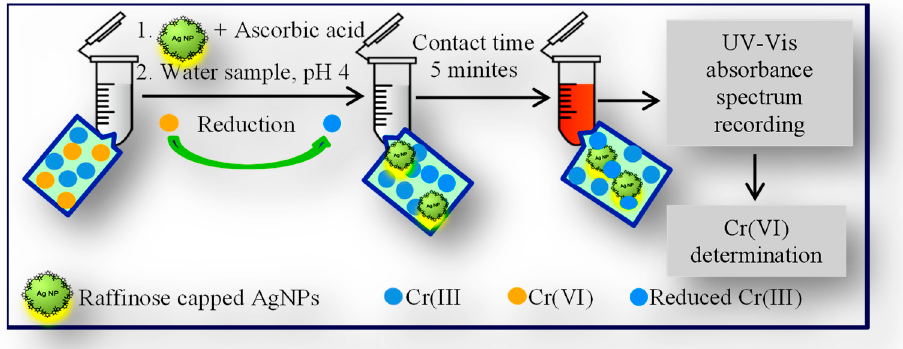
Figure 7. Scheme of analytical procedure for Cr speciation in surface waters using raffinose capped silver nanoparticles as efficient optical sensor for quantification of Cr(VI).